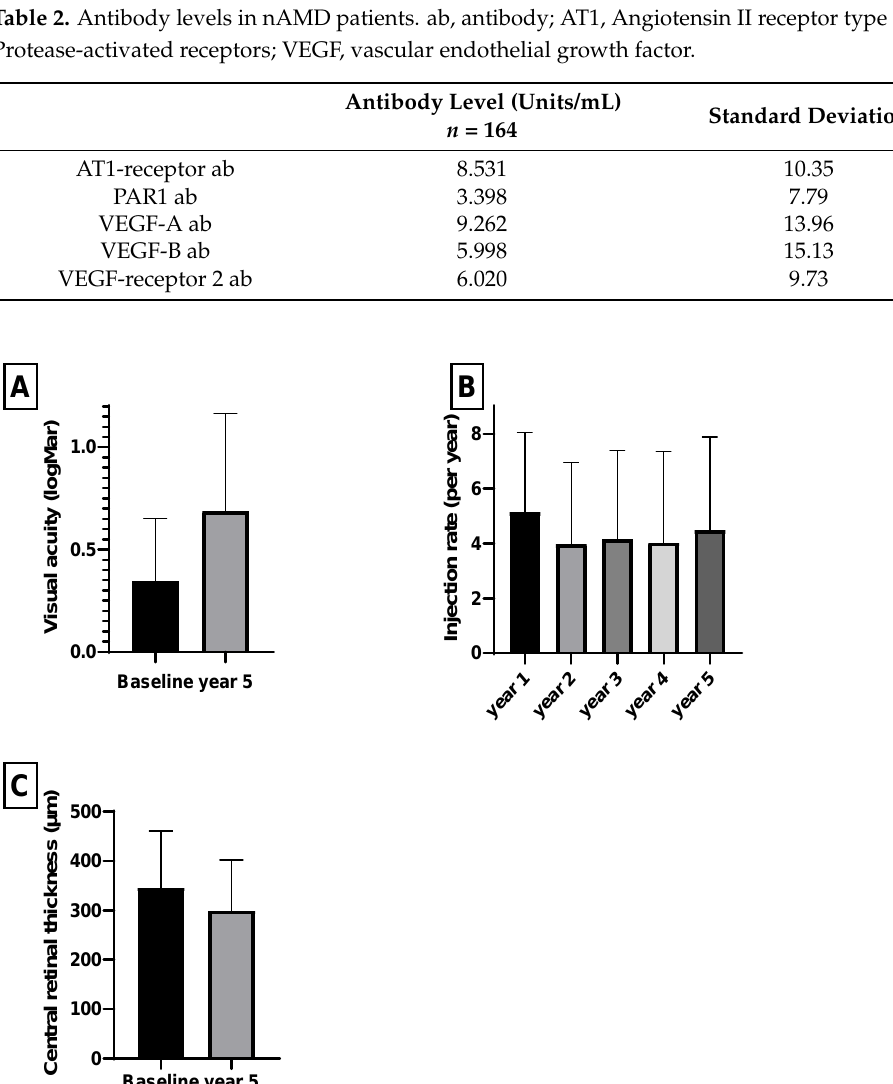
Figure 1. ( A ) Best corrected visual acuity (BCVA) in logMar at baseline and after five years. ( B ) Num- ber of intravitreal injections per year. ( C ) Change in central retinal